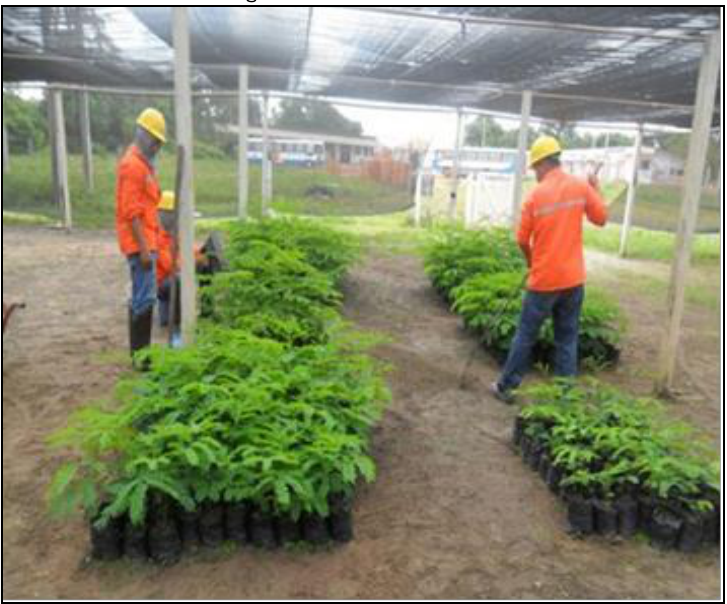
Figure 2: Seedlings of paricá high quality with 35 days of sowing Source: [13].